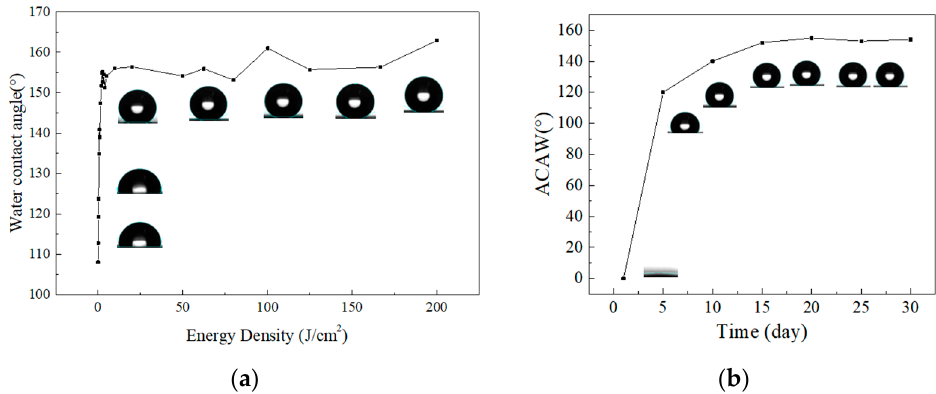
Figure 4. ( a ) The variation of the A apparent contact angle of water (ACAW) of the nickel surfaces with the laser energy density; ( b ) the apparent contact changes over time.